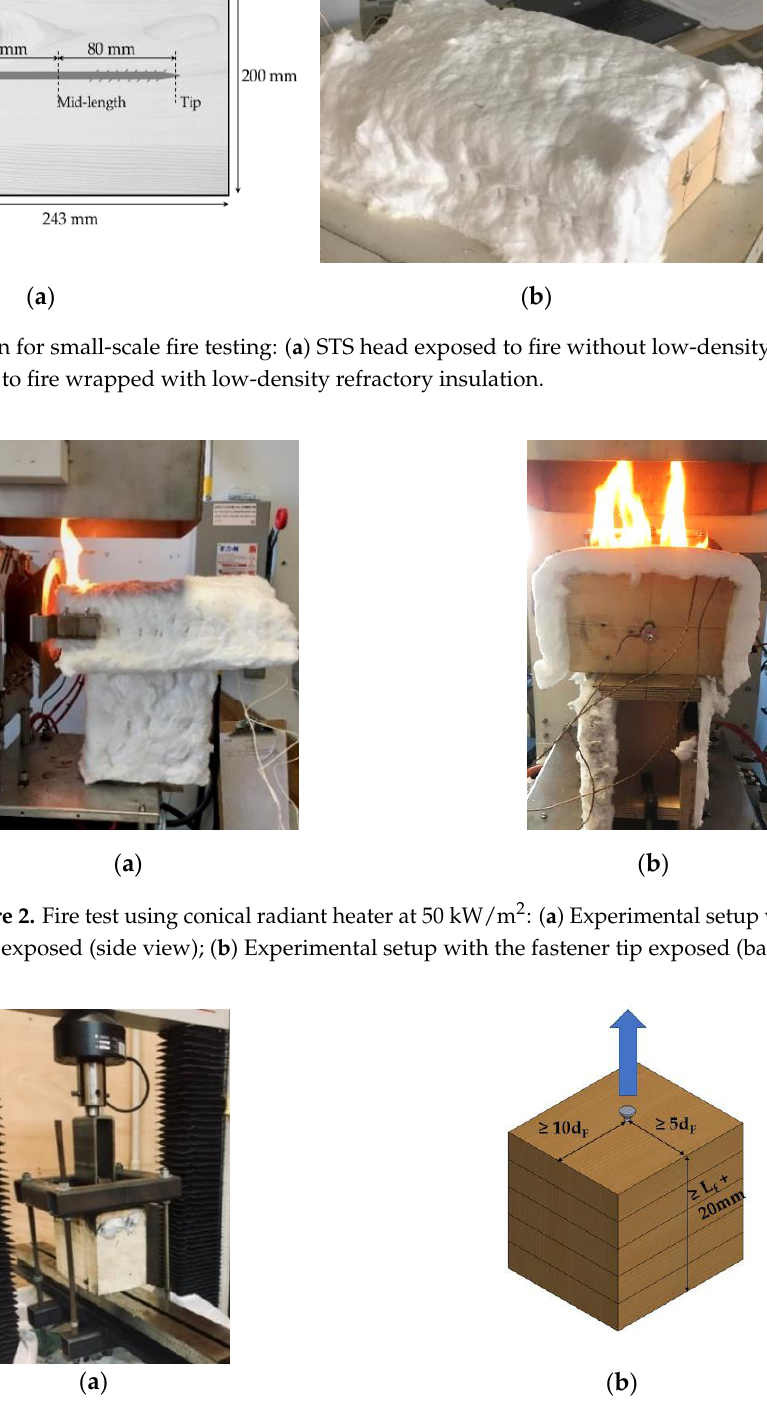
Figure 3. Pull-through STS test: ( a ) Experimental setup for the pull-through test; ( b ) Location of STS across glulam surface.